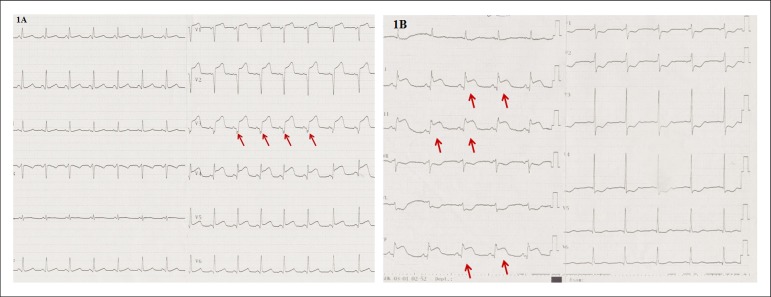
A) ECG example of single lead fQRS in a patient with anterior MI. B)
ECG example of ≥ 2 leads with fQRS in a patient with inferior
MI.